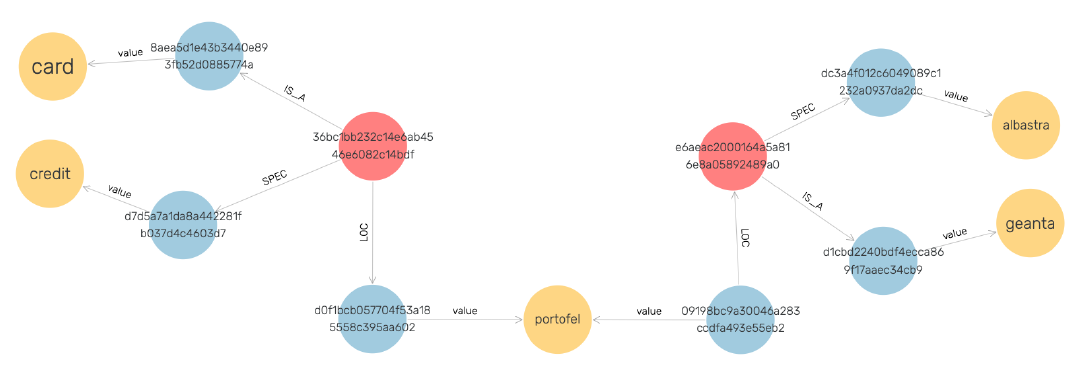
Figure 7. Knowledge sub-graph illustrating a set of dynamically inserted